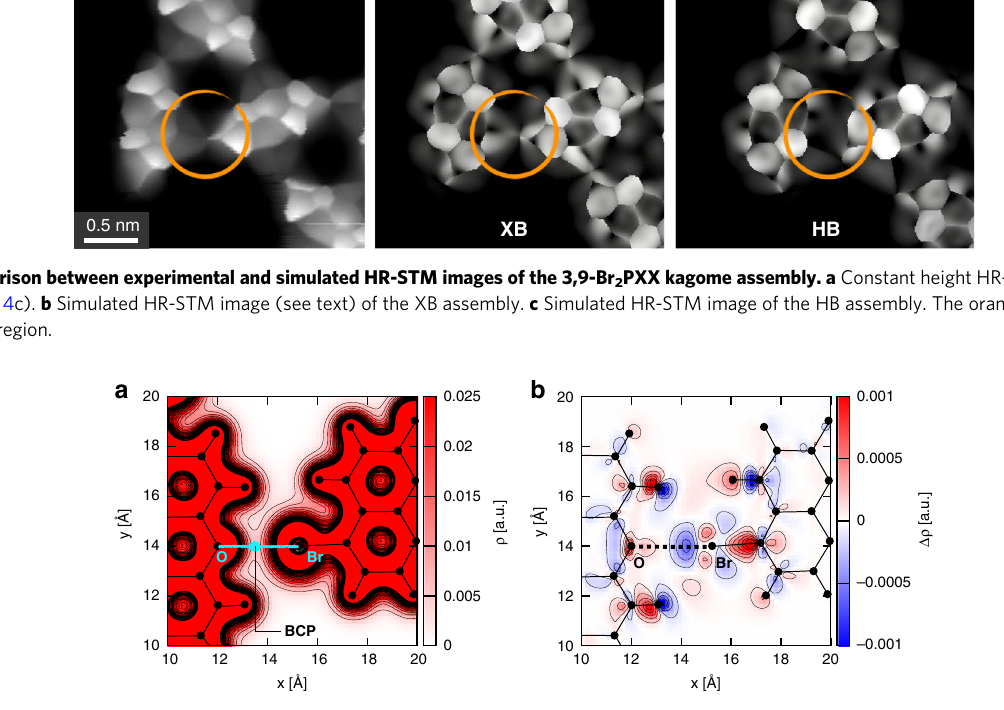
Fig. 6 Analysis of the electron density topology. a Contour map of the electron density ρ projected onto the molecular plane xy . The location of the O and Br atoms is explicitly shown, together with that of the bond critical point, BCP. b Electron density difference Δ ρ , calculated as the difference between the electron density of the dimer and that of the two